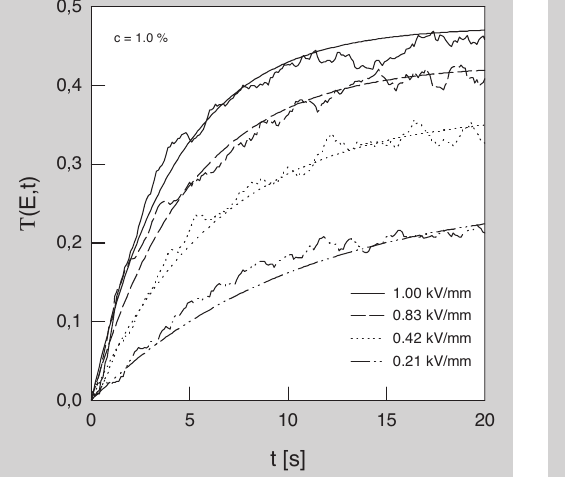
Figure 6 (left): Temporal variation of the transmittance with the electric field intensity as a parameter. The respective approximating functions are also plotted. Figure 7 (right): Some normalized trans- mittance curves (T/T max ), for 0.7 and 1 % concentration samples, are plotted as a function of t/ t 0. Solid line represents the approxi- mating